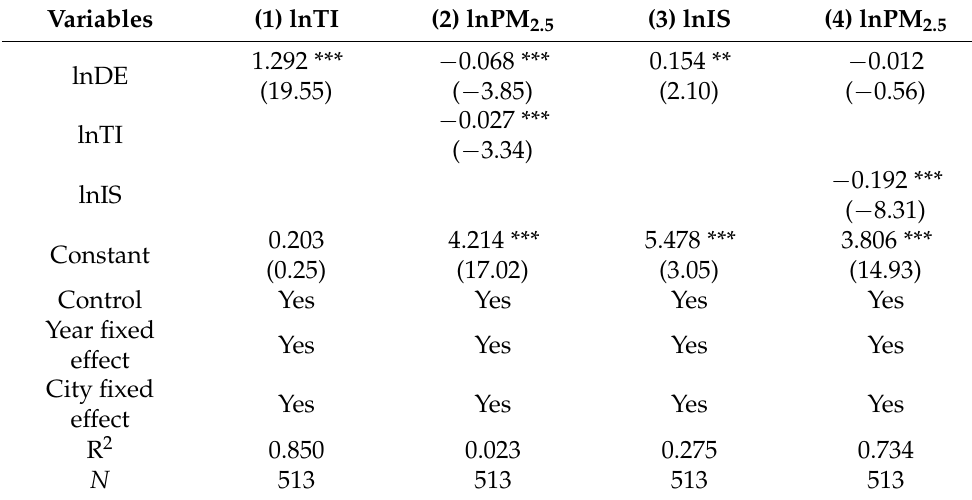
Table 4. Results of the mechanism verification